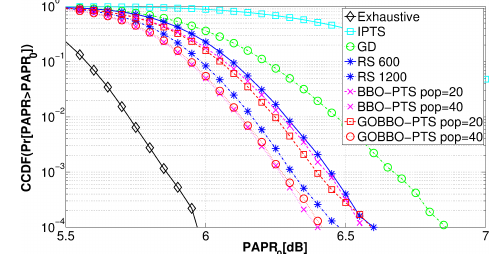
Fig. 5. PARP reduction performance comparison of GOBBO-PTS